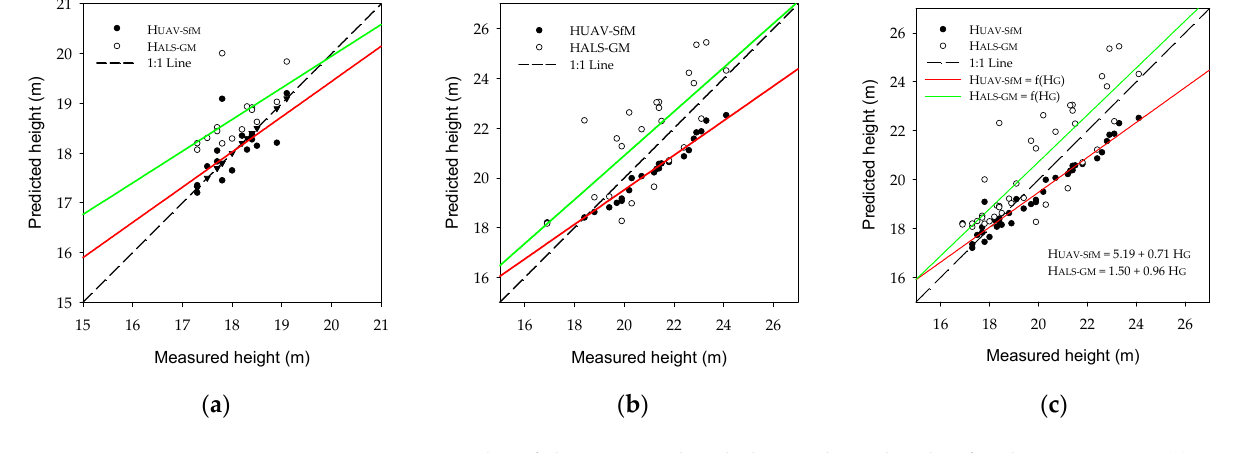
Figure 8. Scatter plot of the estimated and observed tree heights for the Kameyama ( a ), Owase ( b ), and integration of the two ( c ). Dots with red regression lines and circles with green regression lines present H UAV-SfM and H ALS-GM point cloud derived values. In general, the predicted height of UAV-SfM and ALS-GM is linearly correlated to the measured height. In ( c ), the red line shows Y = 5.19 + 0.71X (R 2 = 0.95, p < 0.0001, standard error of estimates = 0.35) for the UAV-SfM; the greed line displays Y = 1.50 + 0.96X (R 2 = 0.73, p < 0.0001, standard error of estimates = 1.20) for the ALS-GM. Table 5. A comparison of tree height determination via the georeferenced UAV-SfM point cloud data and ALS point cloud data.